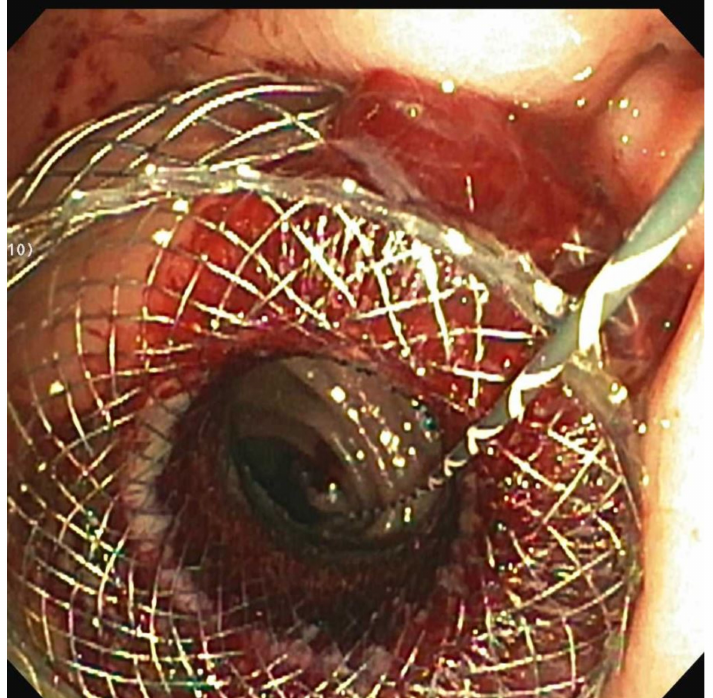
Figure 2. EUS-Gastroenterostomy (EUS-GE): Endoscopic image of a lumen-apposing metal stent deployed between the stomach and the